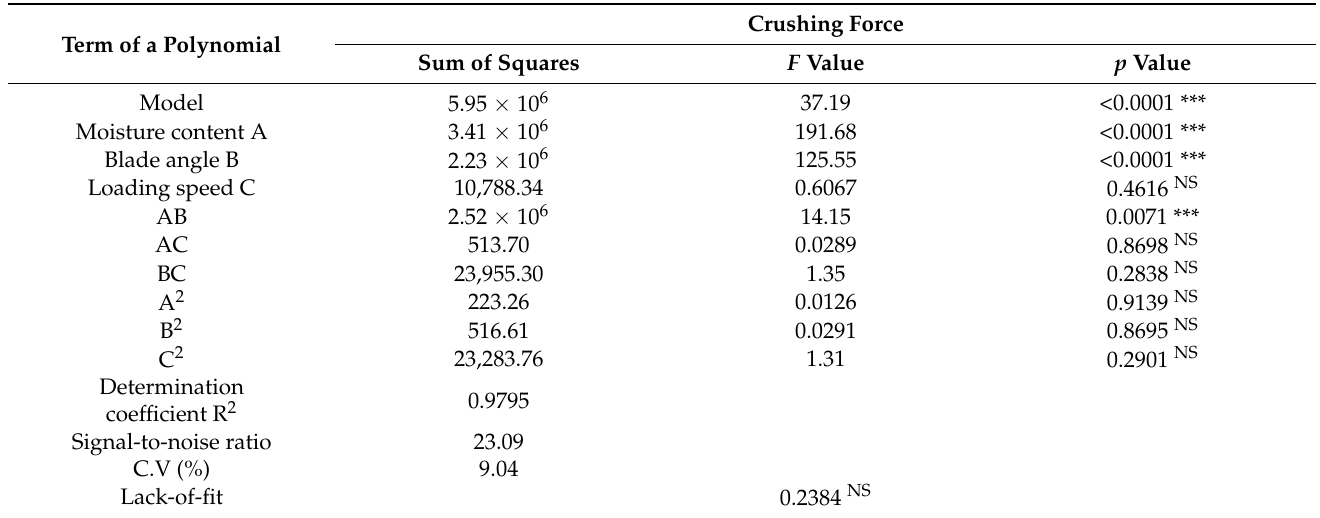
Table 3. Polynomial equation and variance analysis results between the crushing force and test